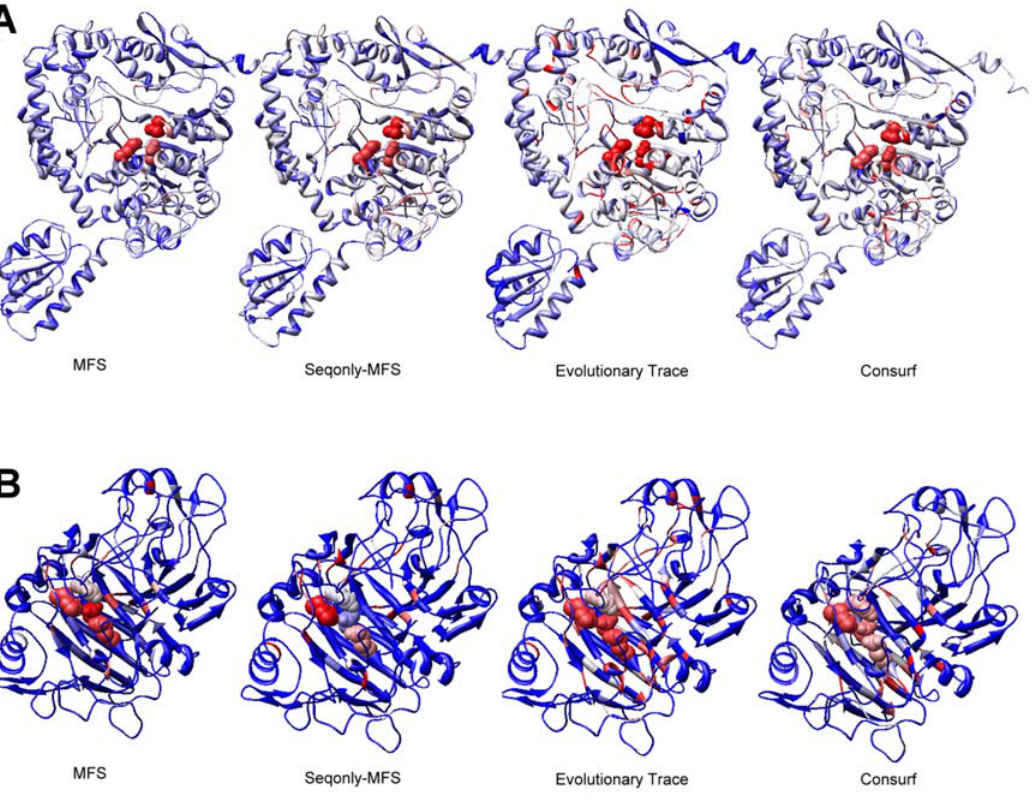
Figure 3. The different predictive performance of the MFS method, the SeqonlyMFS method, the Evolutionary Trace server, and the ConSurf server on two examples. The structure of an ornithine decarboxylase (A) (PDB identifier 1ord-A) and a cellobiohydrolase (B) (PDB identifier 1cel-A) are shown in the ribbon representations with the functional sites (223H-316D-355K in 1ord-A, 212E-214D-217E-228H in 1cel-A) represented as spheres. Each residue is colored by its predicted functional importance score, with the color changing from red to white to blue as the score decreases. For 1ord-A (A), both MFS and SeqonlyMFS work well in assigning the highest scores to the functional sites. However, ET and ConSurf also assign high scores to nearby residues in the surrounding cavity, thus the functional sites do not appear in the top-10 hits lists that are generated by these methods. For 1cel-A (B), all the sequence-based methods are able to assign relatively high scores to the functional sites (different shades of red color), but only the MFS method that uses structural information can boost the scores of the functional sites higher (more intense red color) to show up in the top-10 hits list.